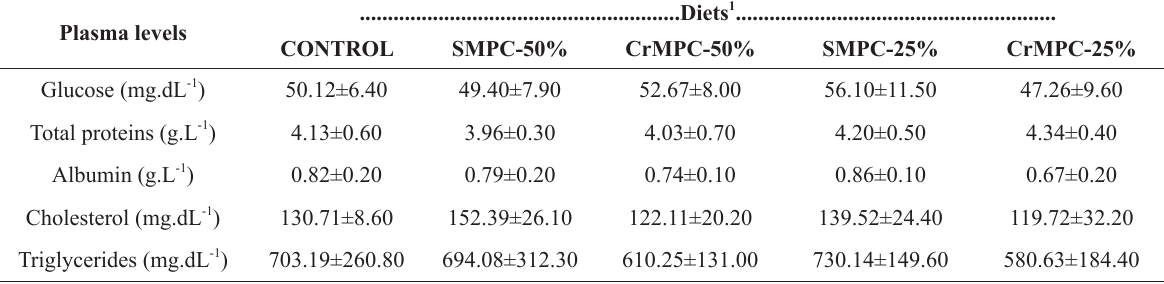
Plasma biochemistry values for silver catfish of different experimental groups fed different experimental diets.